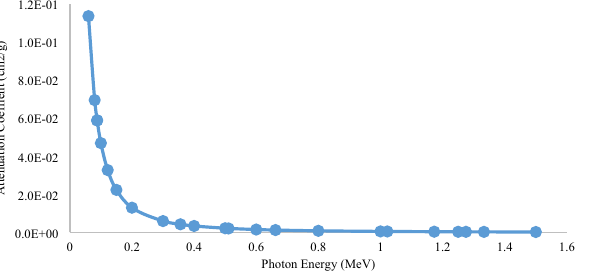
Figure 11. Mass attenuation coefficient of Aluminum Bronze using the XCOM.